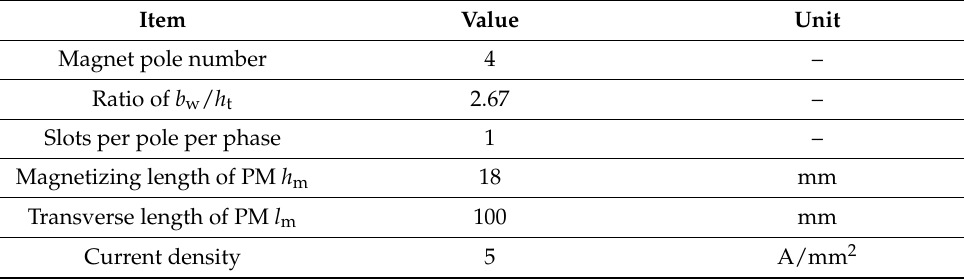
Table 1. Main parameters for the analysis of the PM eddy current.